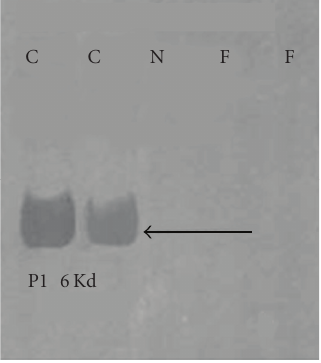
Figure 8: Western blots of protamine 1 in epididymal sperm of sexually mature rats depicting the presence of 6Kd protamine 1 bands in control and absence in drug-treated rats. F: Fluphenazine; C: Control; N: negative control. Basic proteins were extracted in HCl, di ff erentially extracted in trichloroacetic acid, analysed on 15% acid urea PAGE. Western blotting was done with 1Hup 1N monoclonal antibody provided by Dr Rod Balhorn [61].